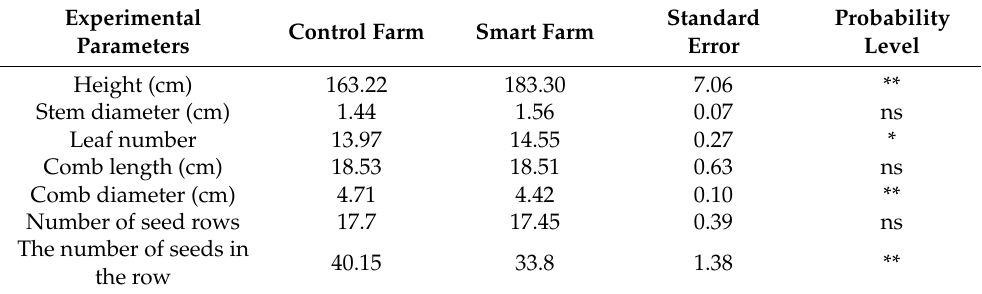
Table 3. Different experimental factors under the influence of different forms of irrigation manage- ment in control and smart farms using t